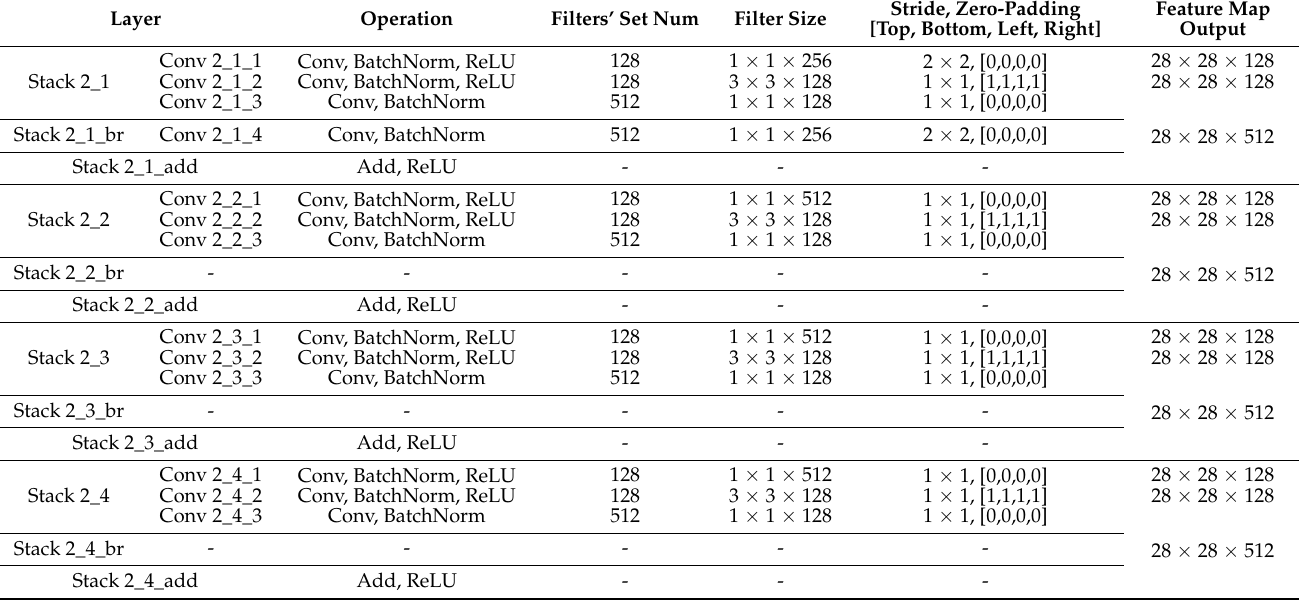
Table 2. CNN feedforward calculation in stack